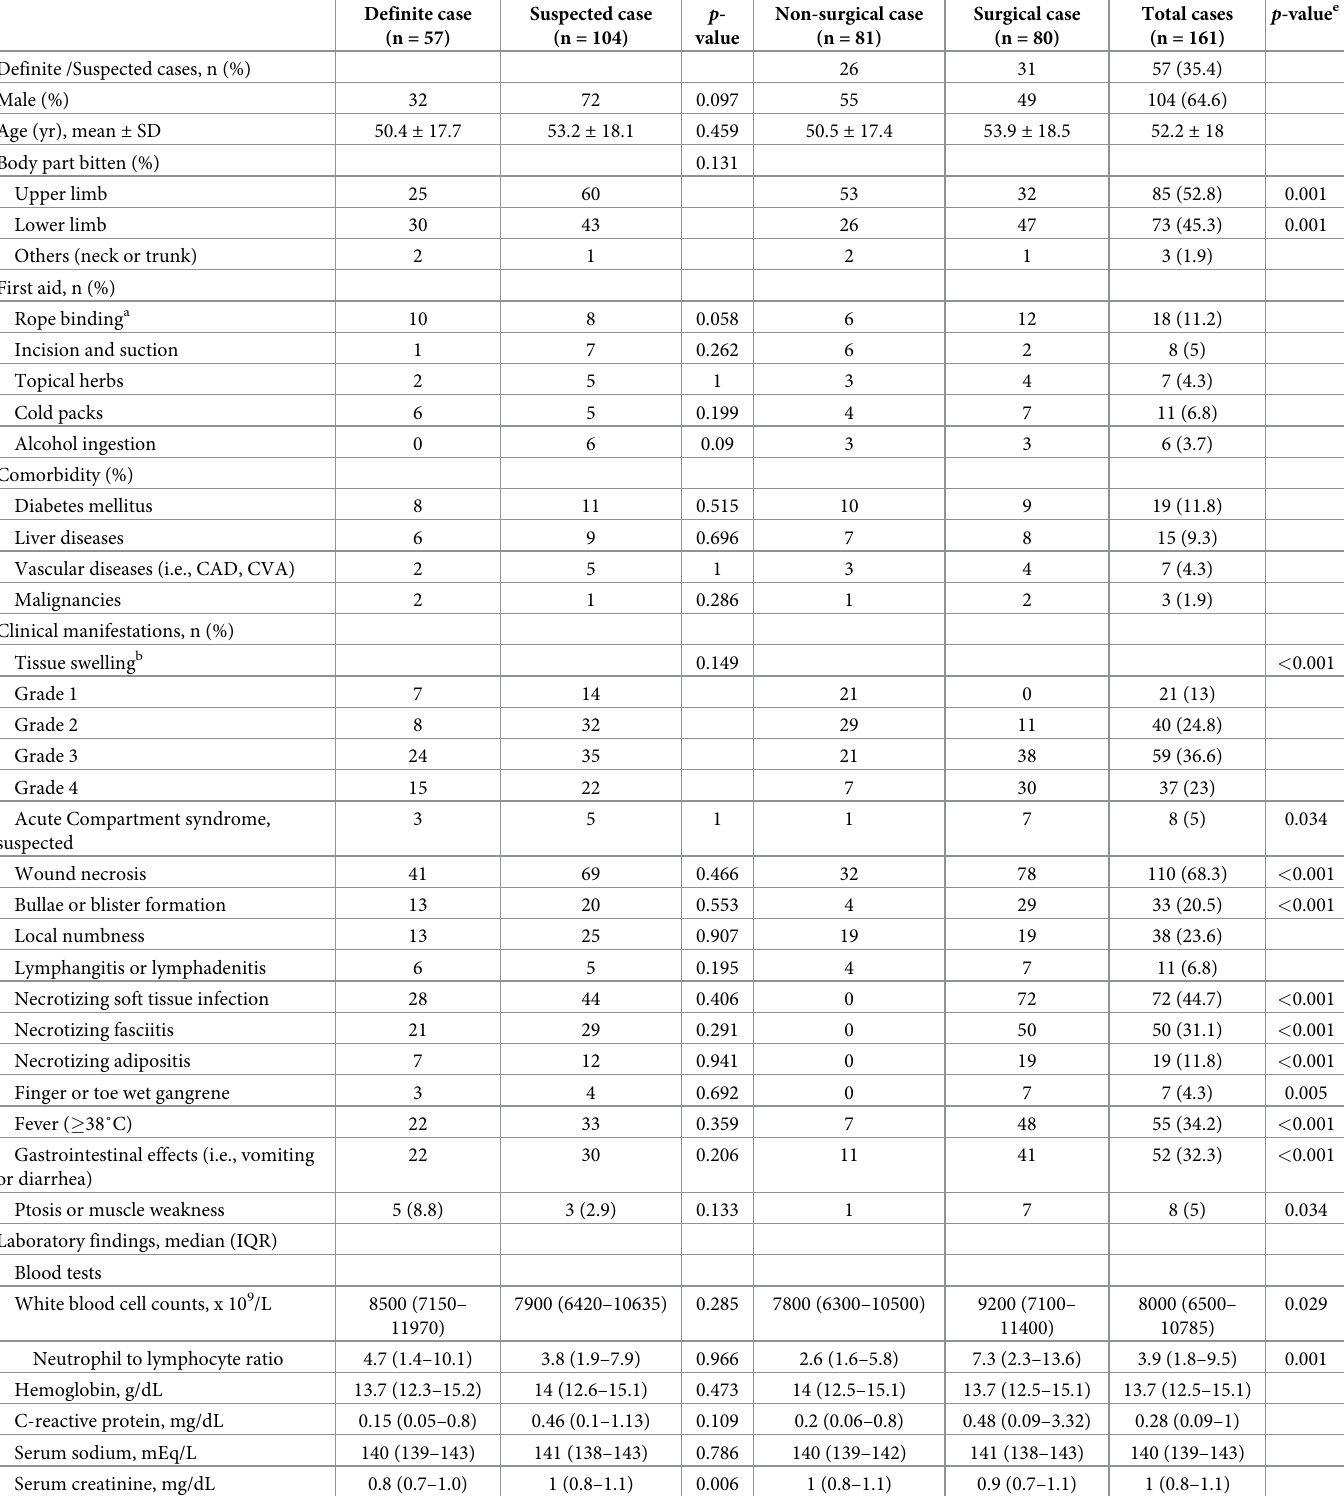
Table 1. Characteristic data, clinical variables, and laboratory findings in 161 Naja atra envenomed